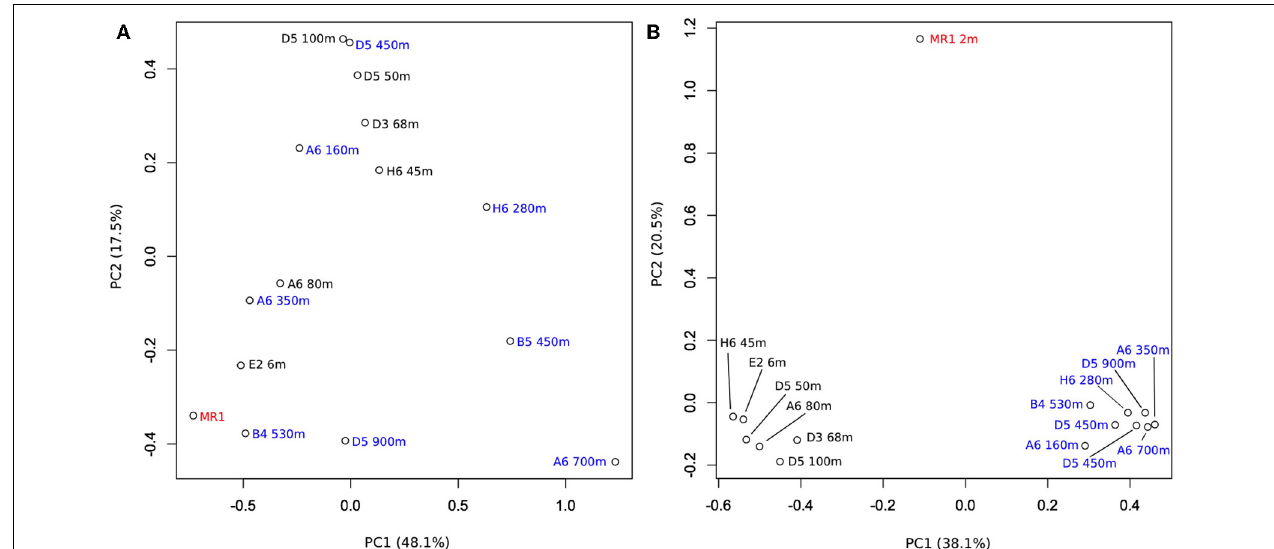
FIGURE 4 | (A) Results of a principal component analysis of alkB gene OPU composition for 15 nGoM sites designated by location and depth. (B) Results of a principal component analysis of 16S rRNA gene OTU composition for the same 15 nGoM sites (data